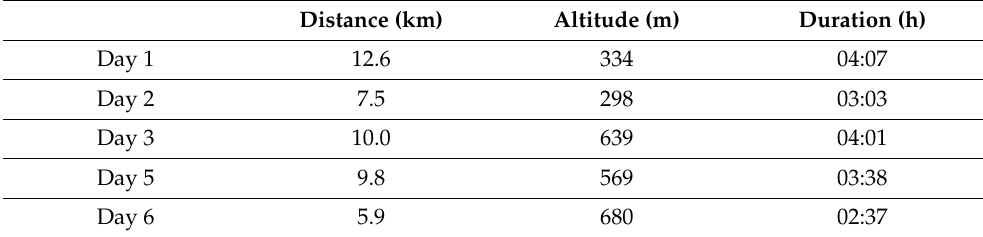
Table 1. Exercise program of the hiking